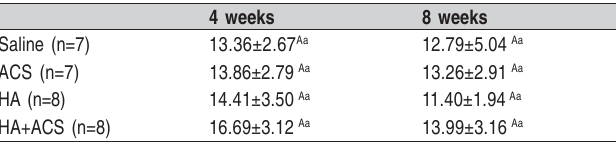
Distinct uppercase letters in rows indicate statistically significant differences among treatments (Two-Way ANOVA, p<0.05). Distinct lowercase letters in columns indicate statistically significant differences between times (Student’s t test;